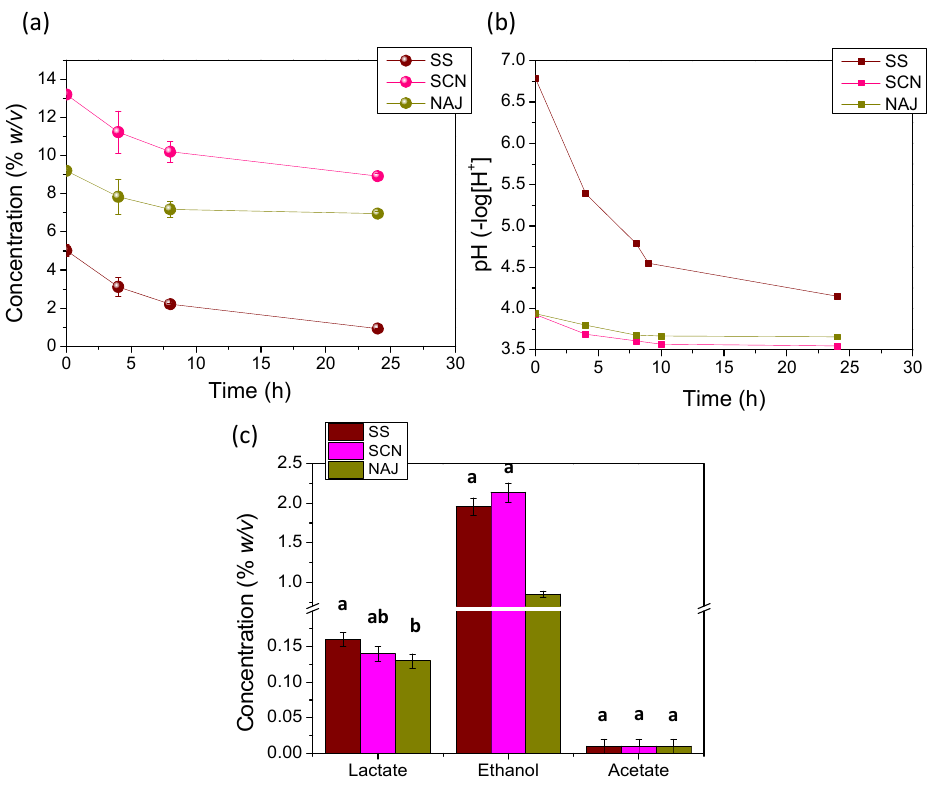
Figure 7. Consumption of sugars ( a ), pH drop ( b ), and distribution of final fermentation products ( c ), during the 24 h fermentation of fermentation of sugary substrates. SS, Sucrose solution; SCN, sour cherry nectar, NAJ, natural apple juice. The same letter above columns of each metabolite, indicate that values do not differ significantly from each other (Mann–Whitney U-test).